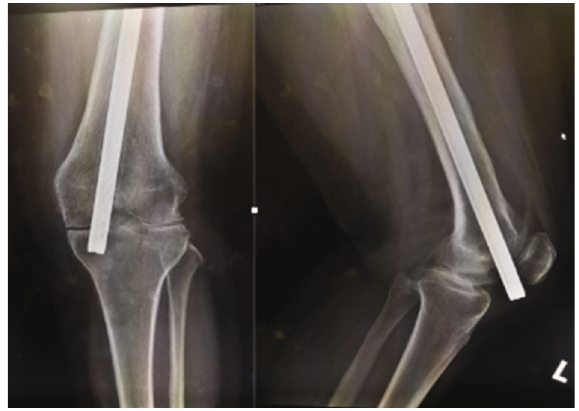
Figure 1: Plain radiograph shows the nail protruded through distal femur.